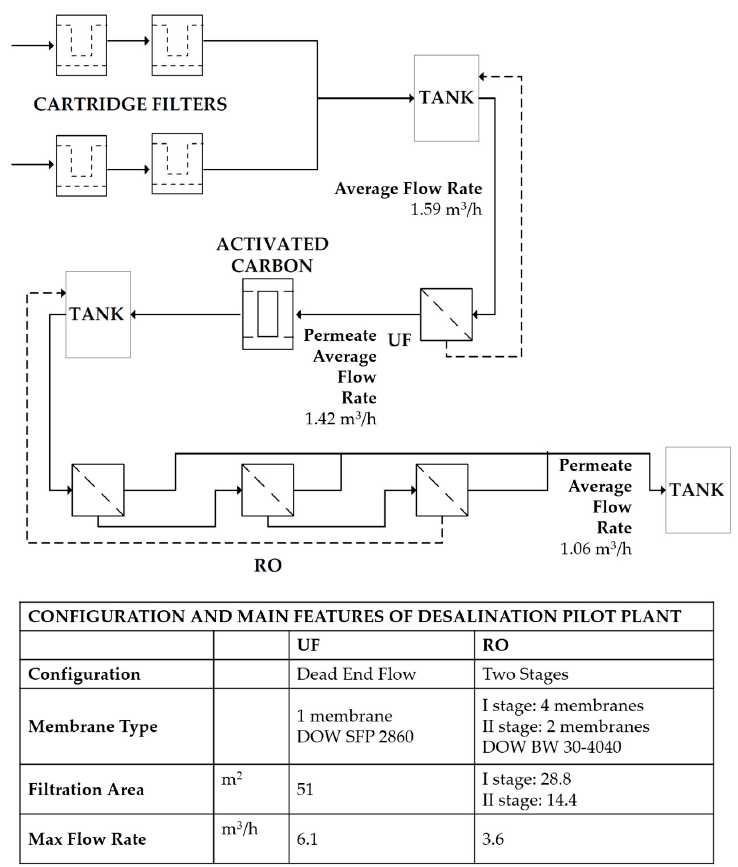
Figure 1. Flowchart diagram (with average experimental flow rates) and main features of desalination pilot plant.